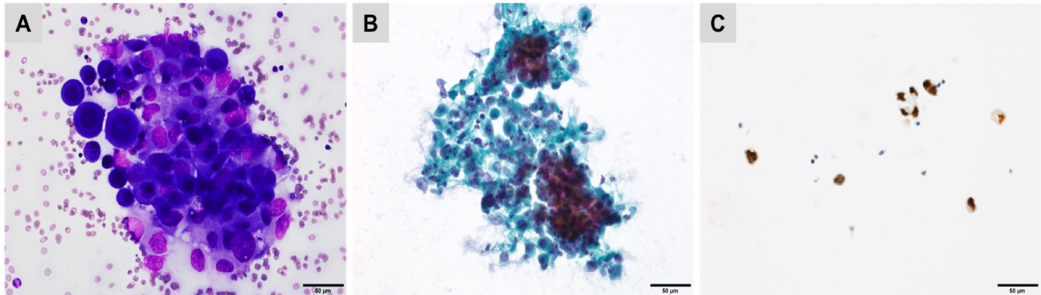
Figure 2. Pleural effusion showing reactive mesothelial cells mixed with metastatic urothelial carcinoma cells (( A ) Giemsa; ( B ) Papanicolaou staining) demonstrating strong nuclear staining for GATA3 ( C ). In addition, other epithelial neoplasms commonly express GATA3 such as cutaneous basal cell carcinomas (98%), cutaneous squamous cell carcinomas (81%), cervical squamous cell carcinomas (33%), skin adnexal tumours (100%), mesothelioma (58%) and chromophobe renal cell carcinoma (51%)